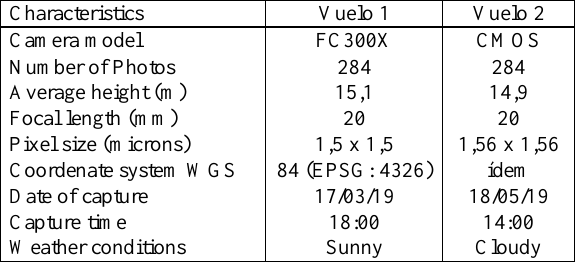
Table 1. Characteristics of the photographic database.